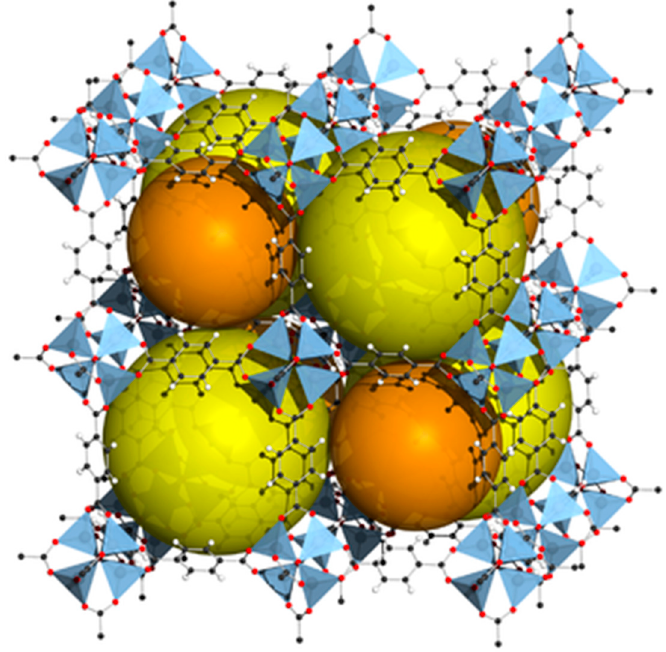
Figure 2. The structure of MOF-5 with orange and yellow spheres showing the pores. [Credit: Tony Boehle].